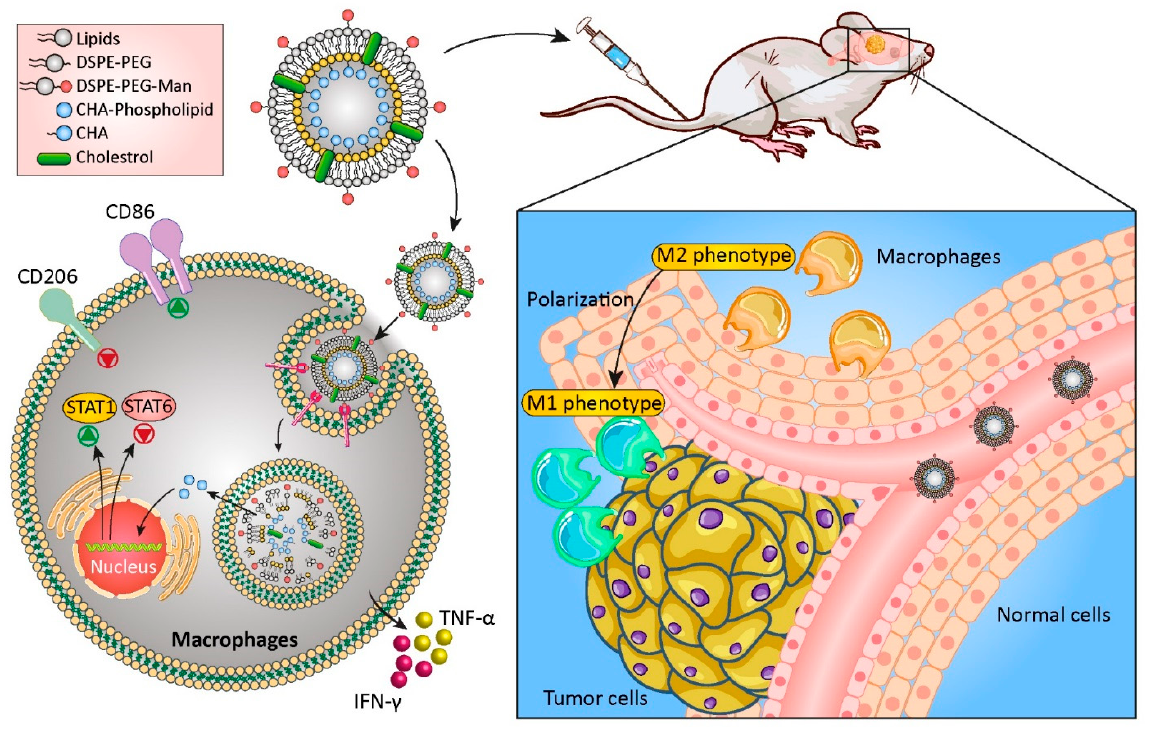
Figure 4. Schematic of applying chlorogenic acid-loaded mannosylated liposomes for immune target- ing GBM therapy. Abbreviations: TMZ: Temozolomide, CHA: Chlorogenic acid, Lipo: Liposomes, DSPE-PEG: 1, 2-Distearoyl-sn-glycero-3-phosphoethanolamine-Poly(ethylene glycol), Man: